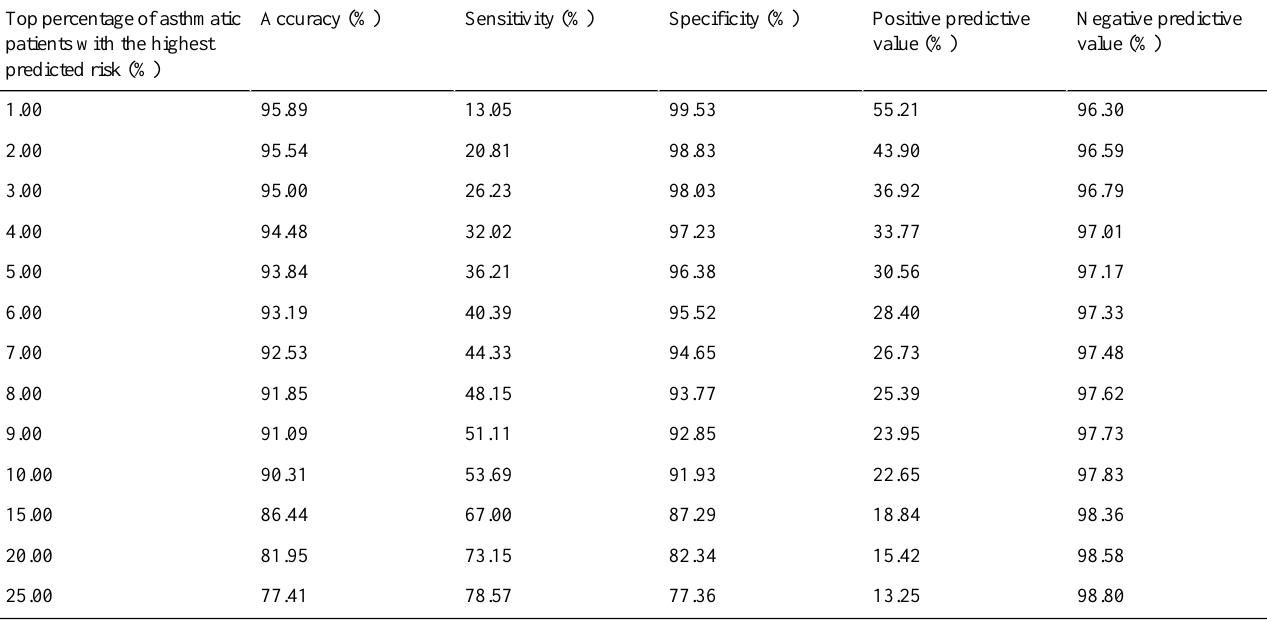
Table 4. Our final model’s performance metrics when differing top percentages of asthmatic patients with the highest predicted risk were used as the cutoff threshold for conducting binary classification.